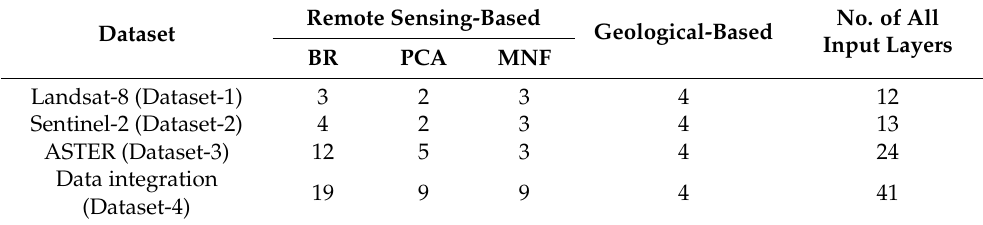
Table 4. Input layers of each dataset to conduct data-driven MPM.